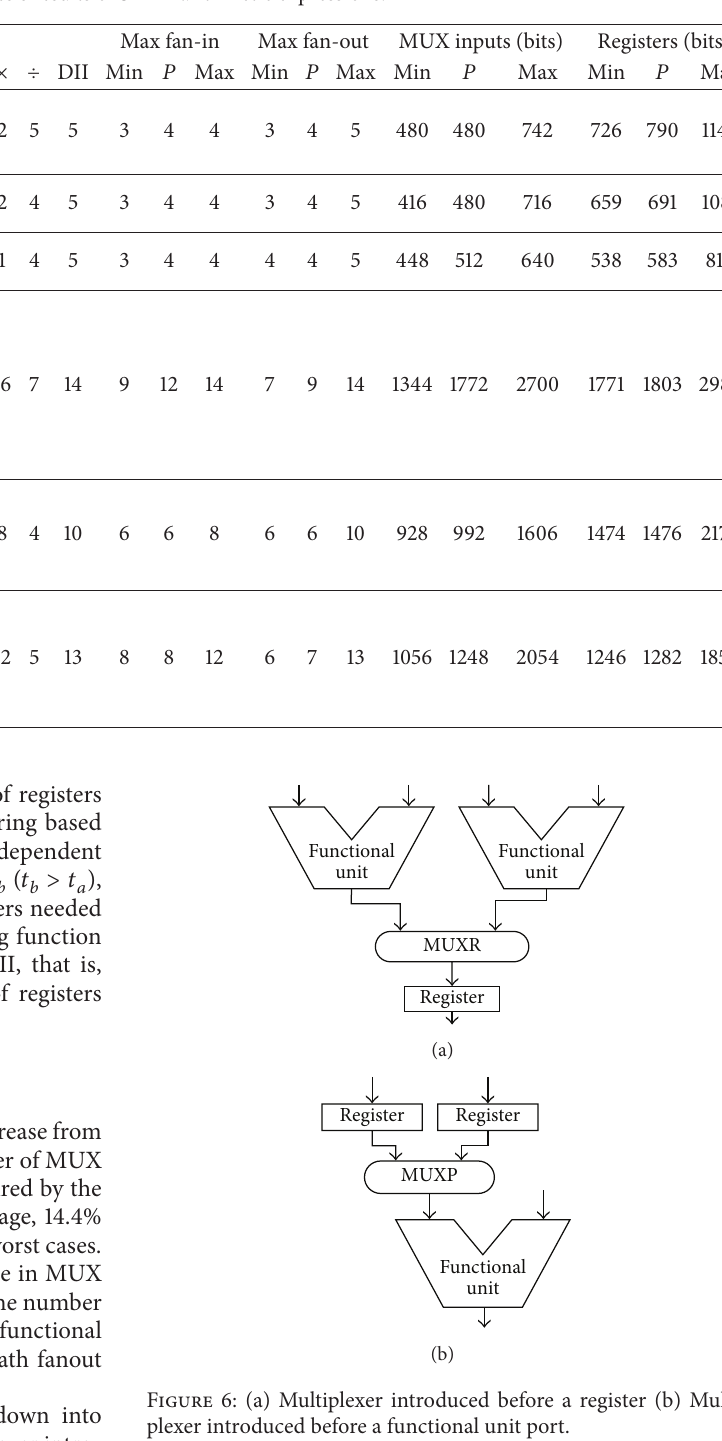
Table 2: Synthesis results of SMBL arithmetic expressions.